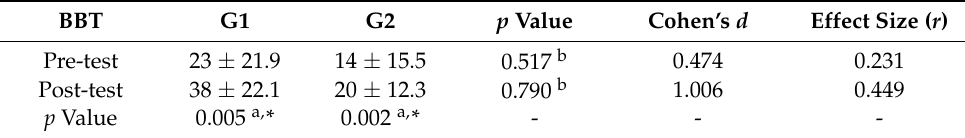
Table 3. Box and block test (BBT) of affected UE in both